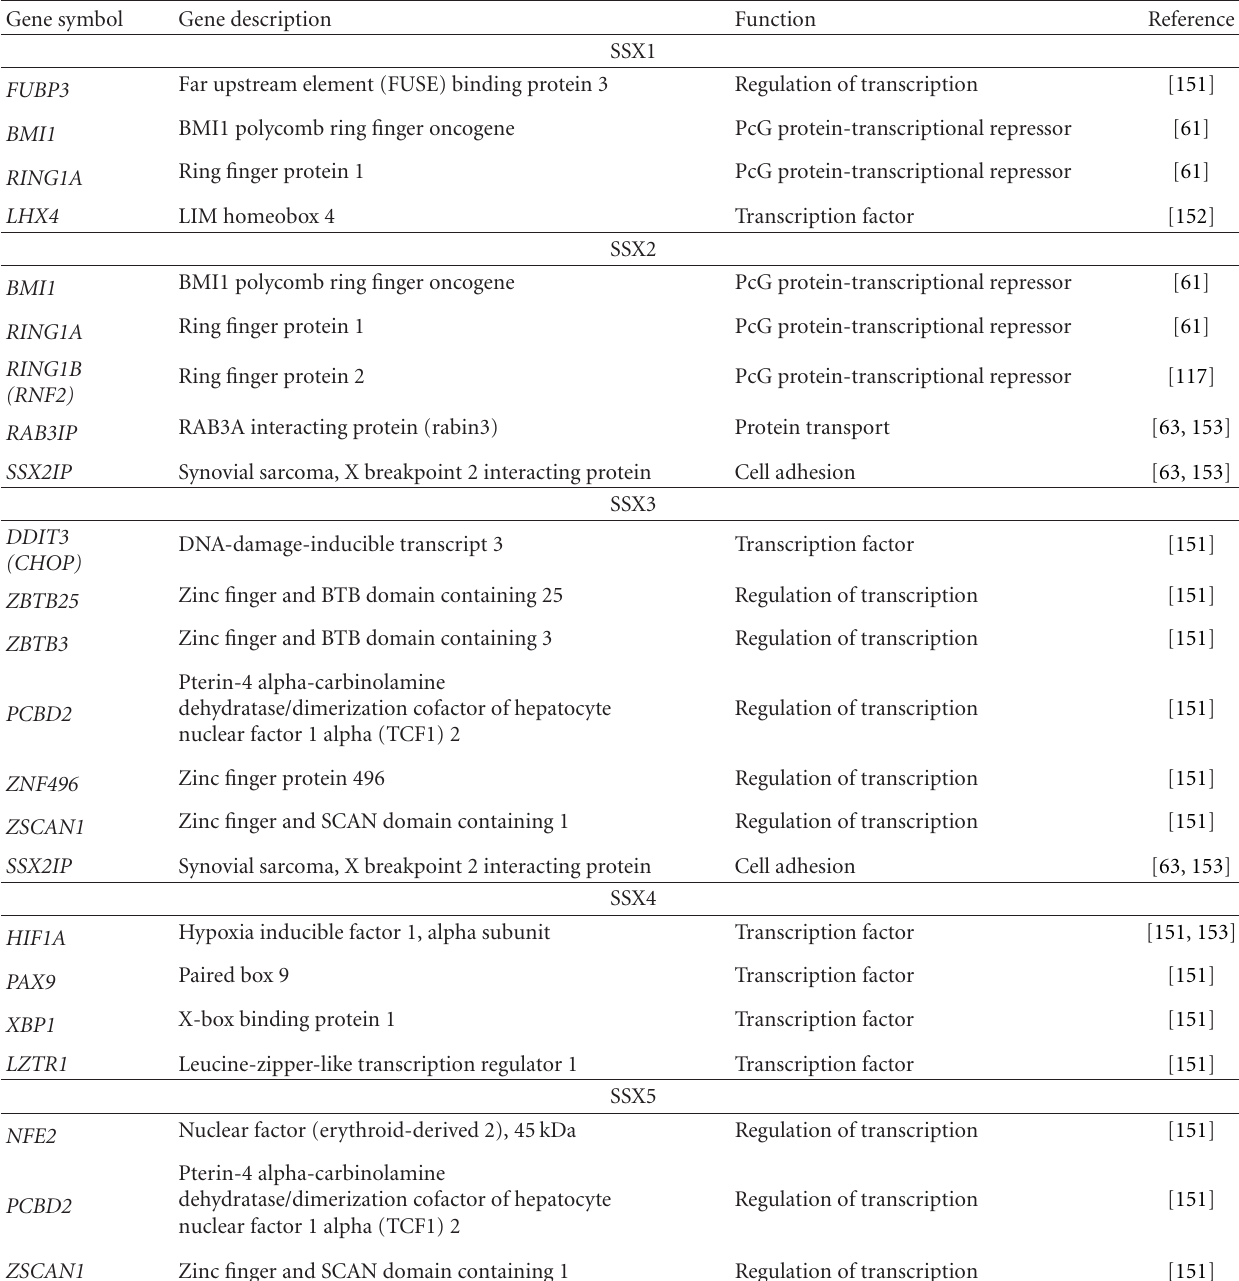
Table 1: Interactors of SSX